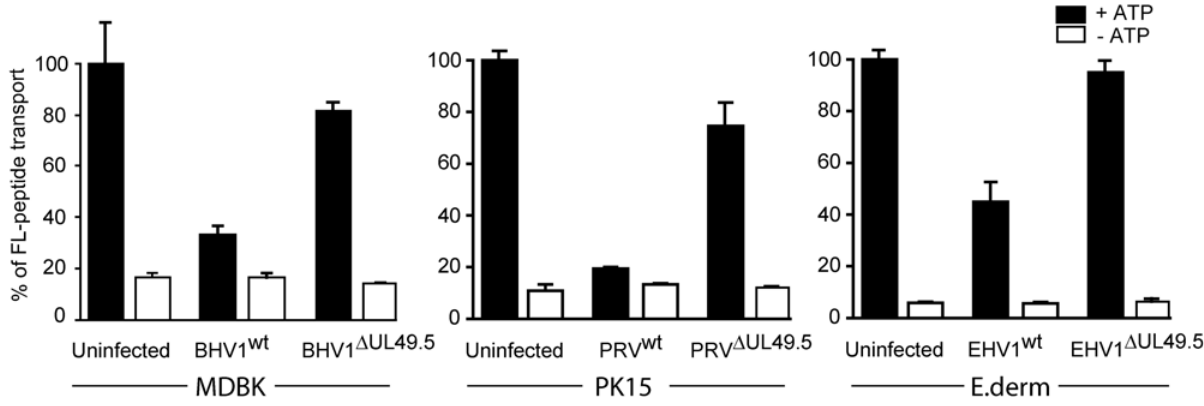
Figure 4. UL49.5 is responsible for TAP-inhibition in virus-infected natural host cells. Bovine cells (MDBK), porcine cells (PK15), and equine cells (E.derm) were infected with wild type BHV-1, PRV, or EHV-1, respectively, or with the corresponding UL49.5-negative recombinant viruses. In all experiments, mock-treated (uninfected) cells from the relevant host species were used as a control. Peptide transport was assessed at 5 hrs post- infection in the presence and absence of ATP (black and open bars, respectively). The data are expressed as percentage of translocation, relative to the translocation observed in control cells (defined as 100%).